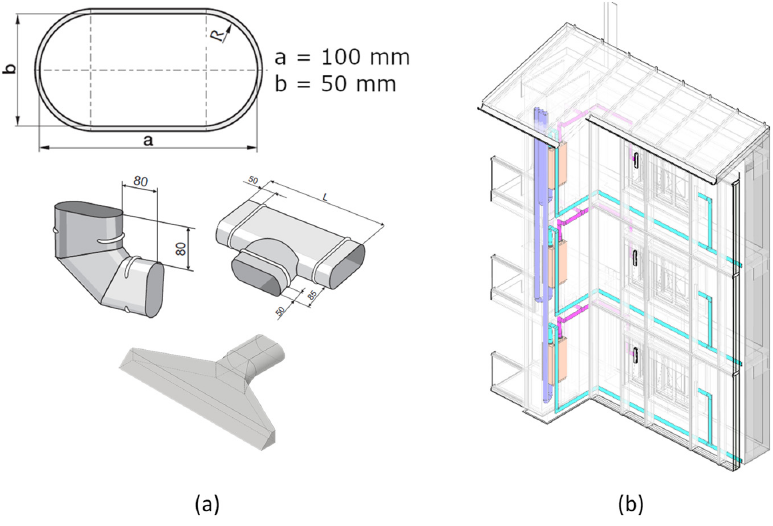
Figure 9. ( a ) Ventilation system: components; ( b ) system diagram (measurements in mm).